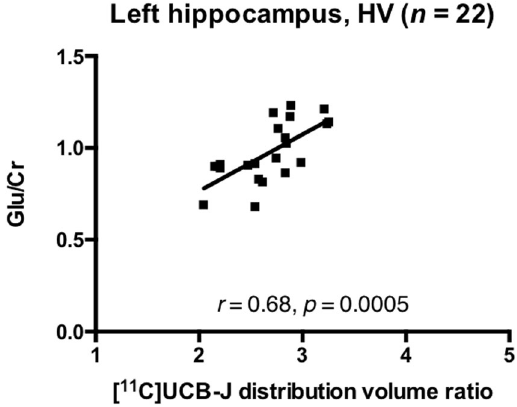
Fig. 1 Synaptic density and glutamate in healthy volunteers. Signi fi cant positive relationship between [ 11 C]UCB-J distribution volume ratio and Glu/Cr levels in the ACC in the healthy volunteer (HV) group. ACC = anterior cingulate cortex.